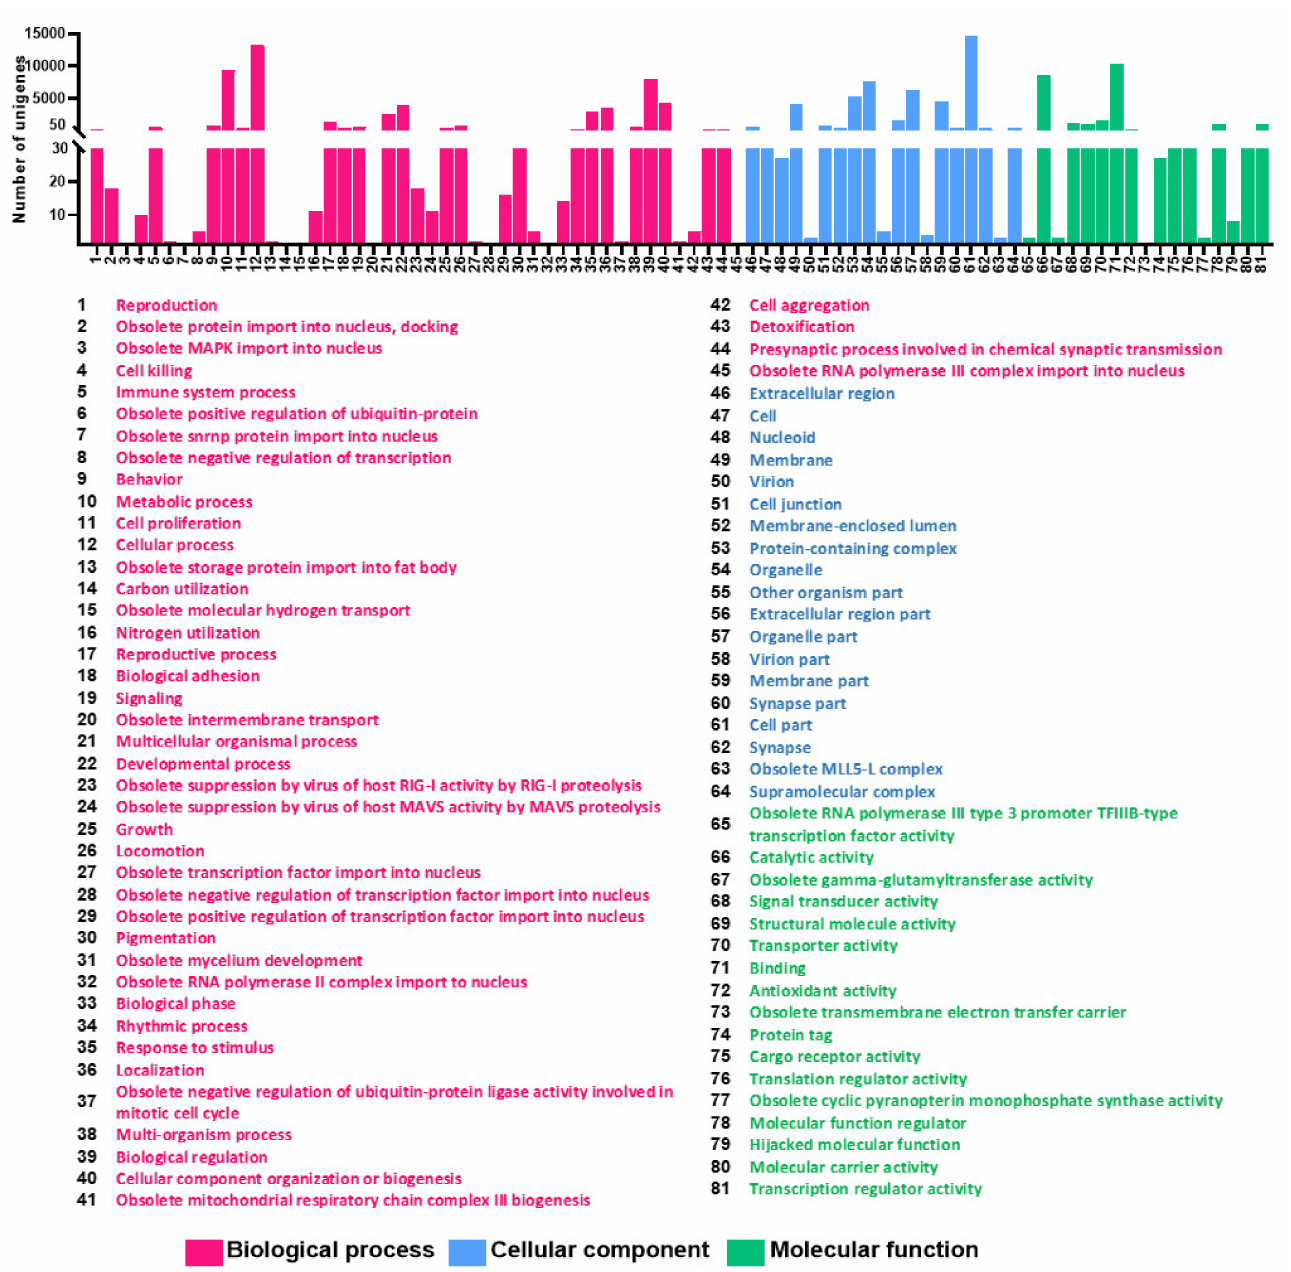
Figure 1. Annotations of the annotated unigenes. The Gene Ontology (GO) classification of all annotated unigenes. A total of 20,645 unigenes were assigned to three main GO categories of ‘Biological process with 45 functional subcategories’, ‘Cellular component with 19 functional subcategories’ and ‘Molecular function with 17 functional subcategories’. The Y -axis shows the number of genes in each category. The numbers on the X-axis in each figure correspond to functional subcategories for which a definition is